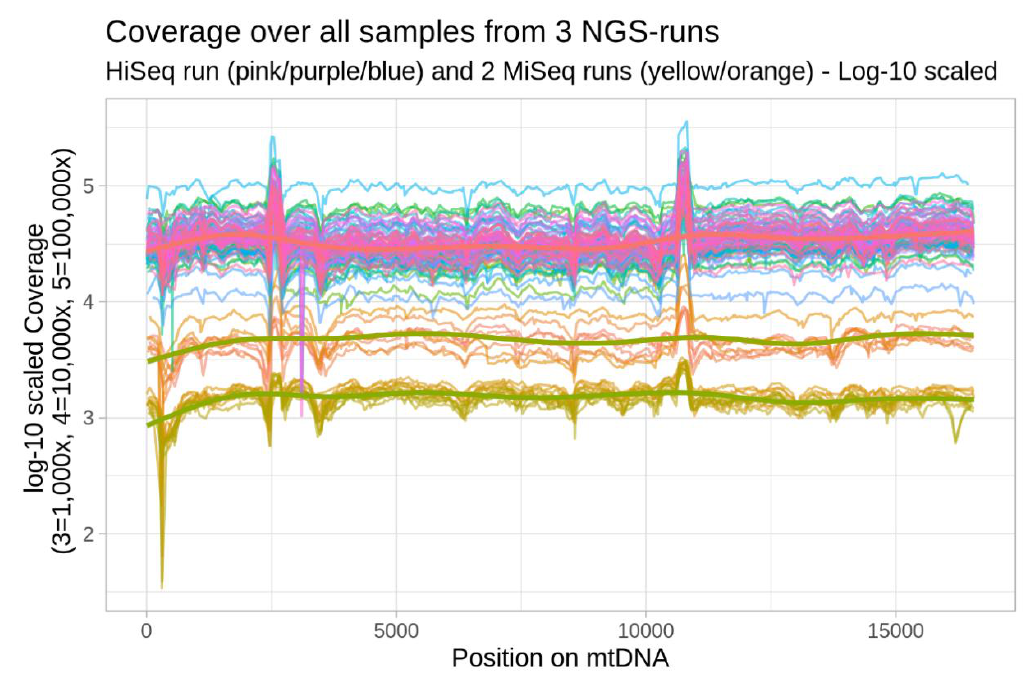
Figure 1. Distribution of the per-base coverage for all 74 specimens sequenced in the three different runs. The X-axis represents the mitochondrial positions 1–16,569, while the Y-axis displays the perbase read coverage on a log − 10 scaled axis. The mean coverage depth was 5210× for MiSeq run one, 1547× for the MiSeq run two and 36,220 × for the previously published HiSeq data.